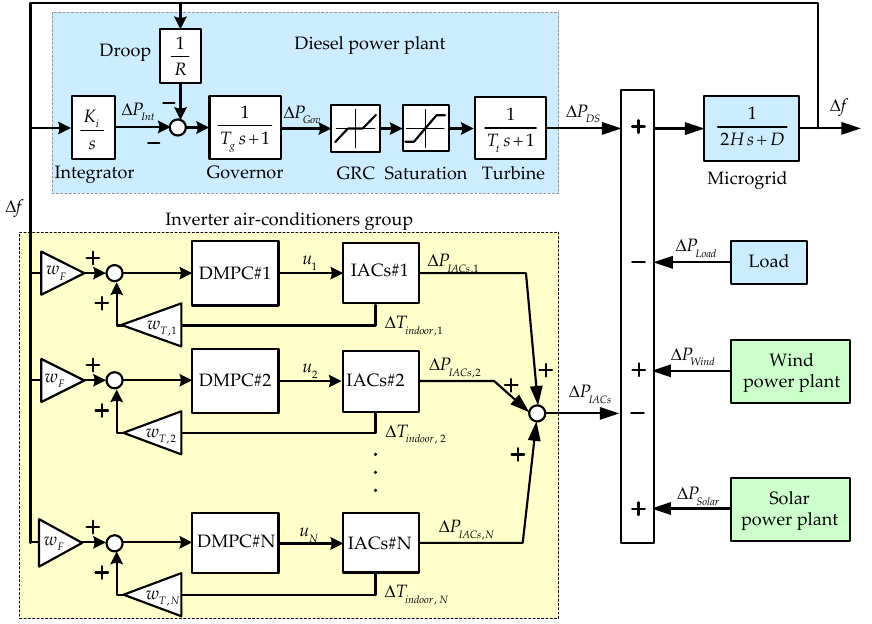
Figure 2. Linearized model of the study microgrid with DMPC. Figure 2 displays the linearized model of the studied microgrid. The IACs are con- trolled by the DMPC, as shown in Figure 3. The system parameters are shown in Table 1.